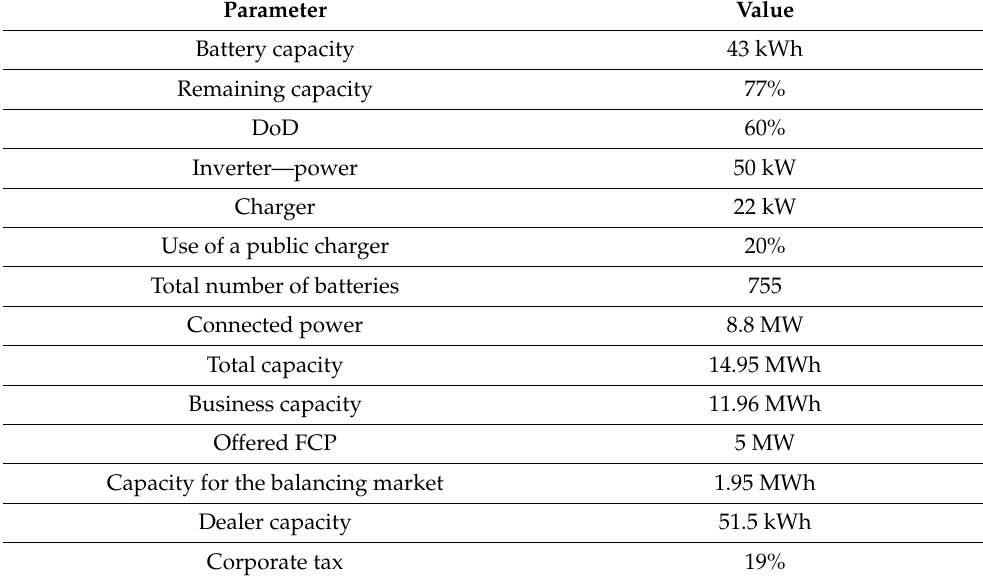
Table 16. Output investments.